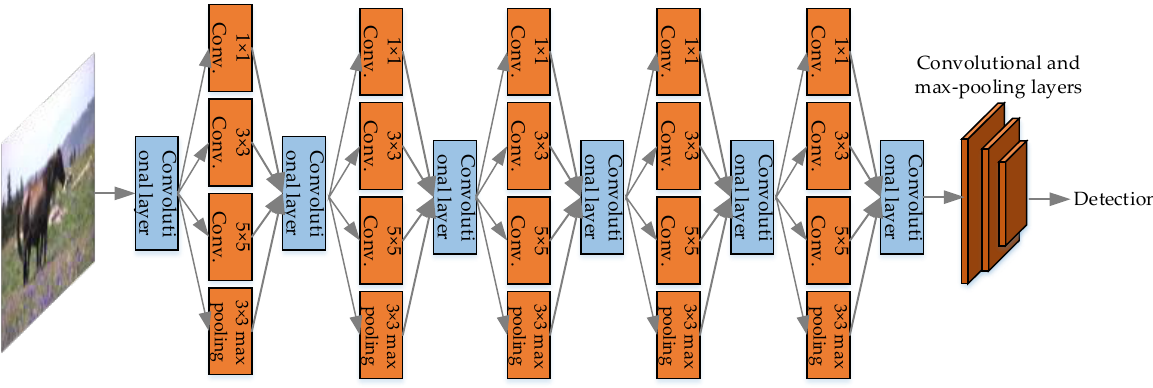
Figure 6. The structure of using-dilated-convolution UAV detection, which has 5 Inception mod- ules.